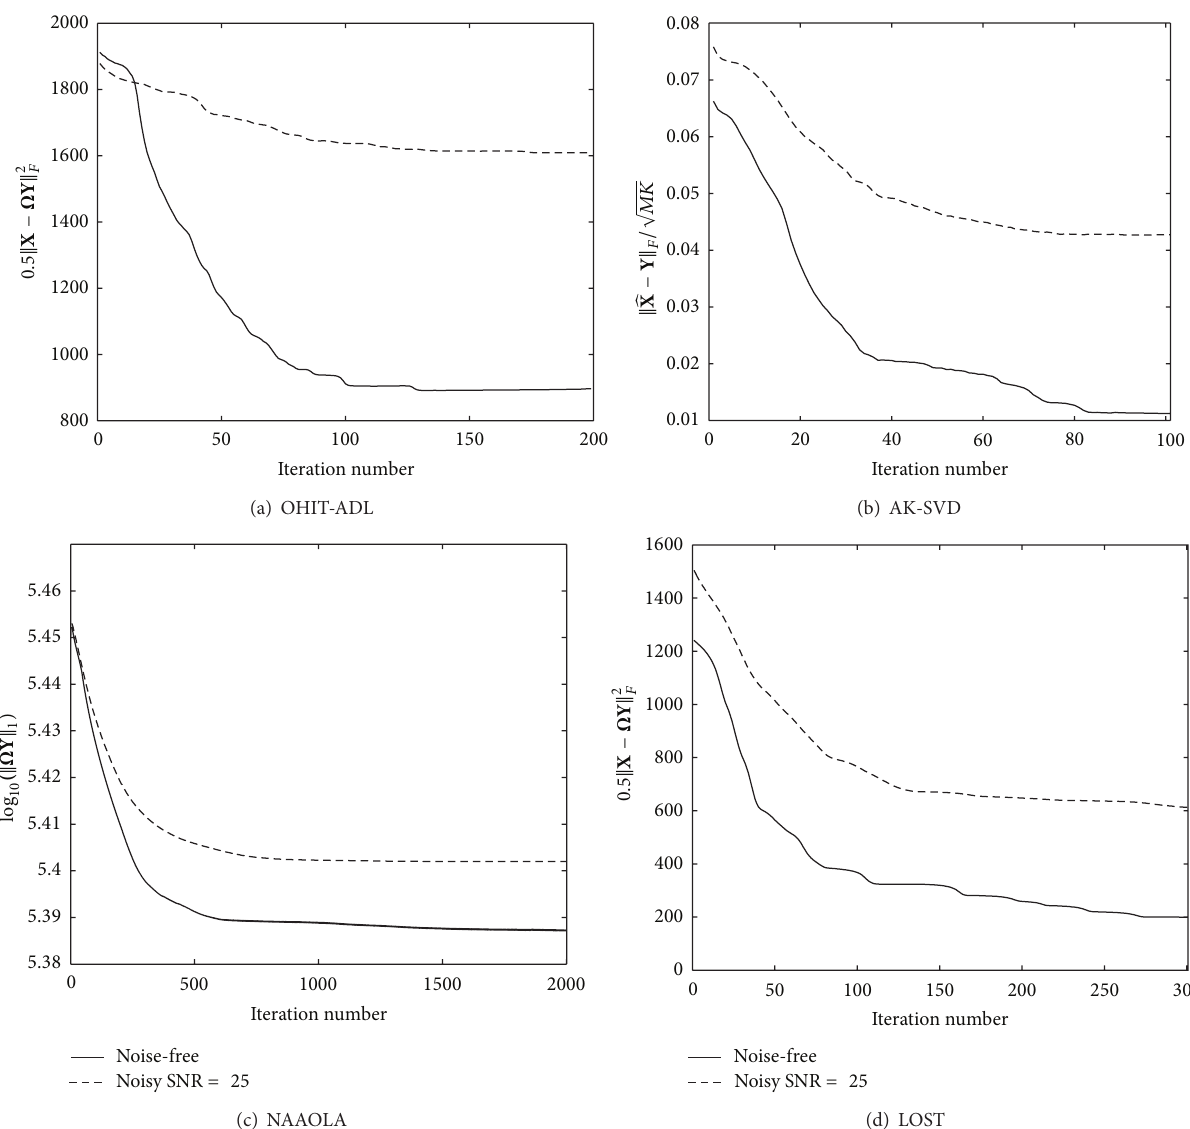
Figure 1: The convergence curves of the ADL algorithms for both the noise-free and noise case (where SNR = 25dB).